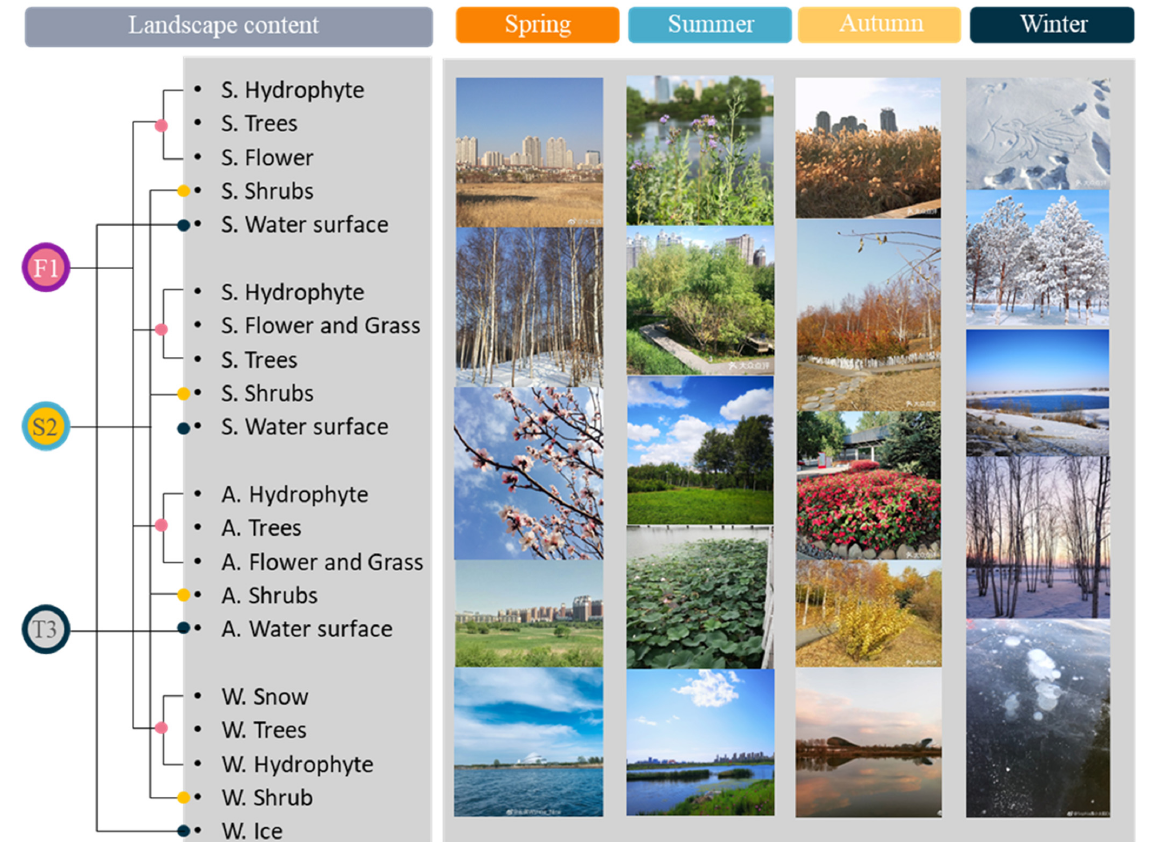
Figure 4. Focus on landscape elements in the four seasons (F1: the element with the highest attention